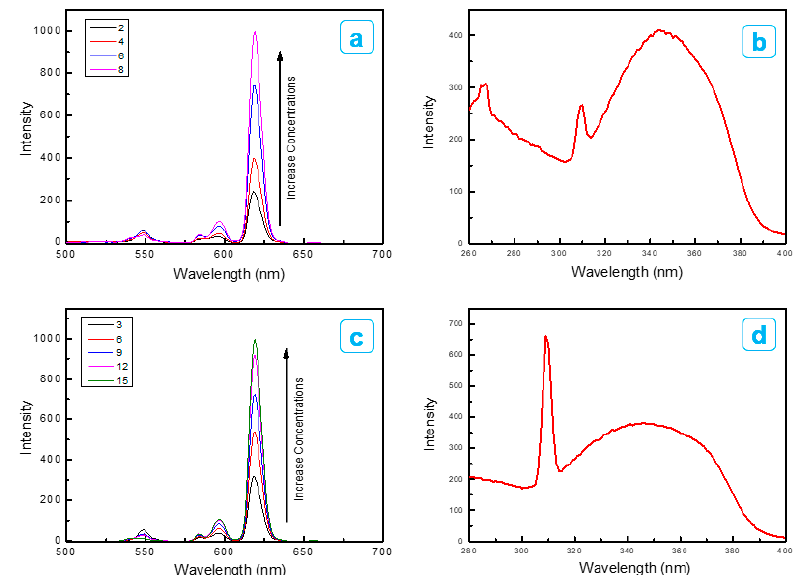
Figure 6. ( a ) Emission spectrum ( λ ex at 350 nm) and ( b ) excitation spectrum ( λ em at 621 nm) Eu(TFTB) 2 (MAA)P(Oct) 3 dispersed in water and ( c ) Emission spectra ( λ ex at 342 nm) and ( d ) excita- tion spectrum ( λ em at 621 nm) at 298 K for 5 D 0 → 7 D j transition depending on different concentration of Eu(TFTB) 2 (MAA)P(Oct) 3 @poly(St- co -MAA) dispersed in water.